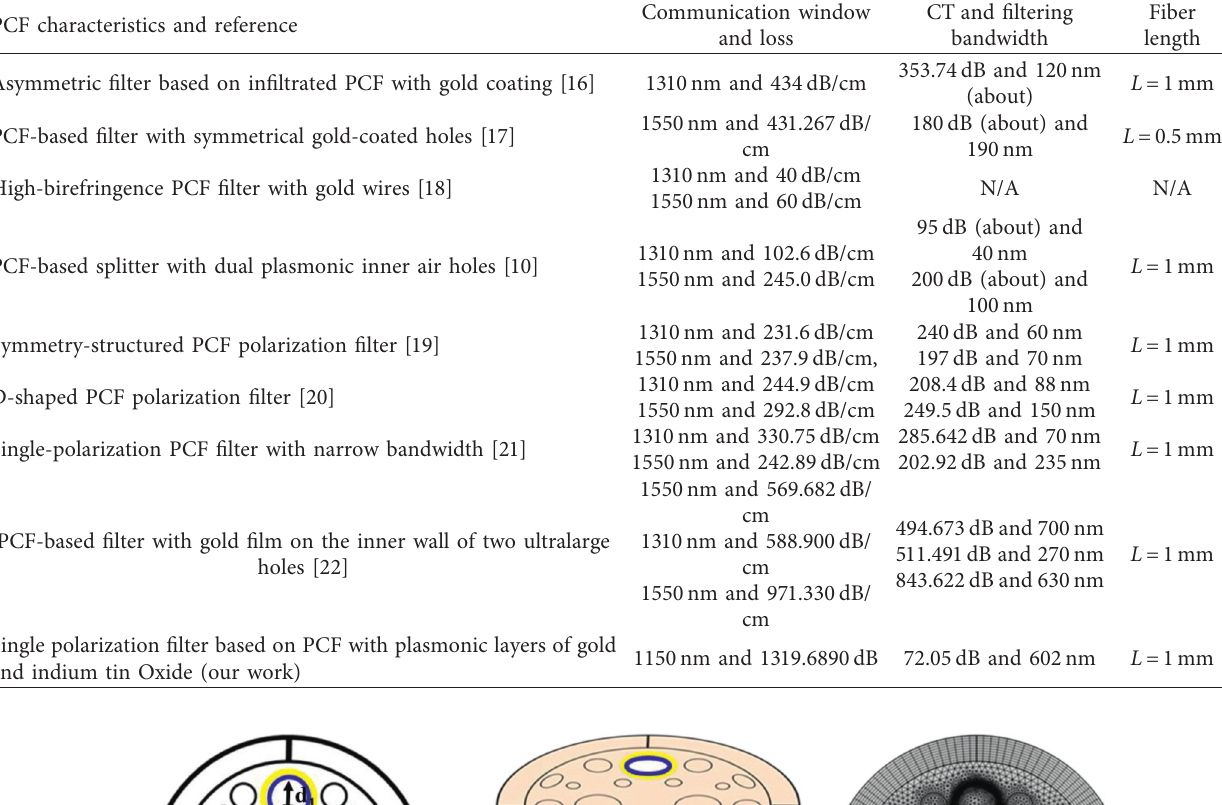
Table 1: Comparisons of polarization filter